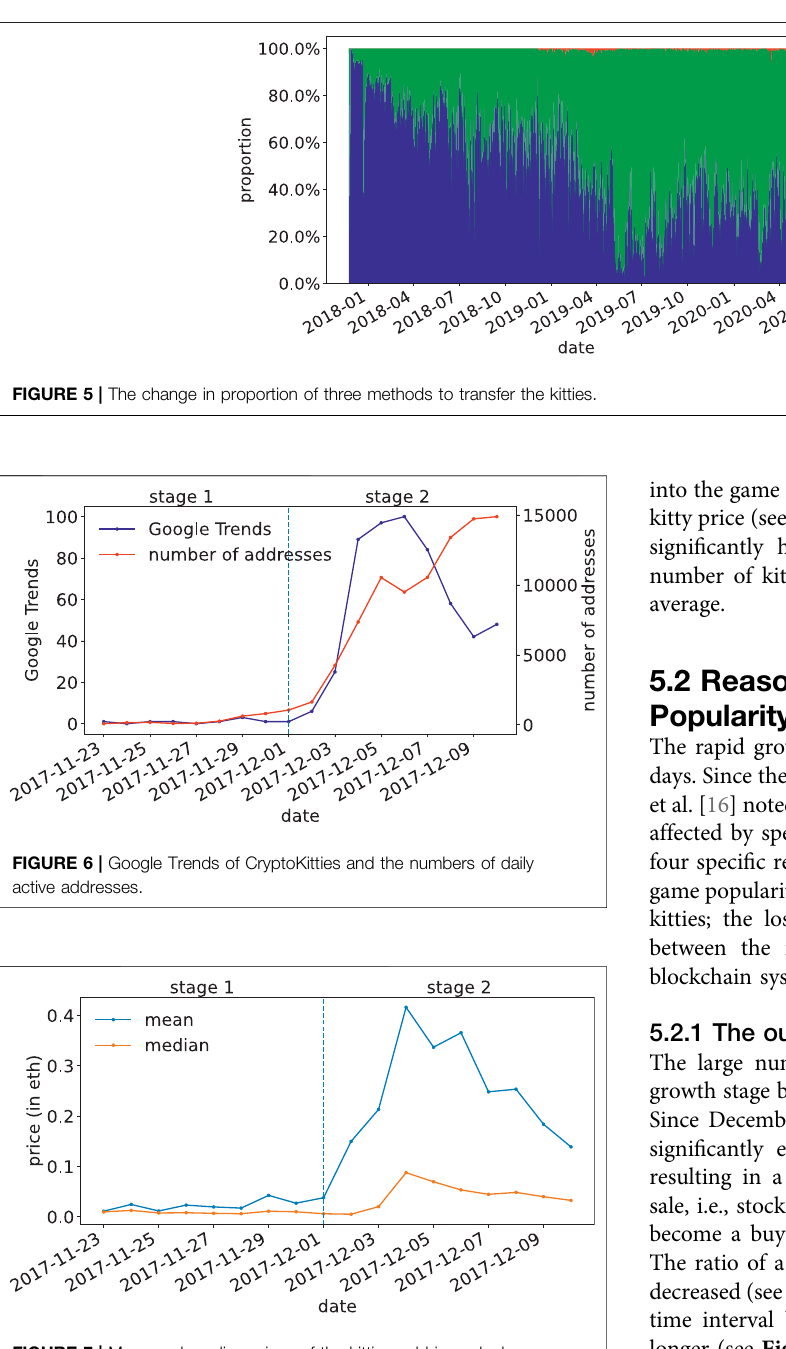
FIGURE 7 | Mean and median prices of the kitties sold in each